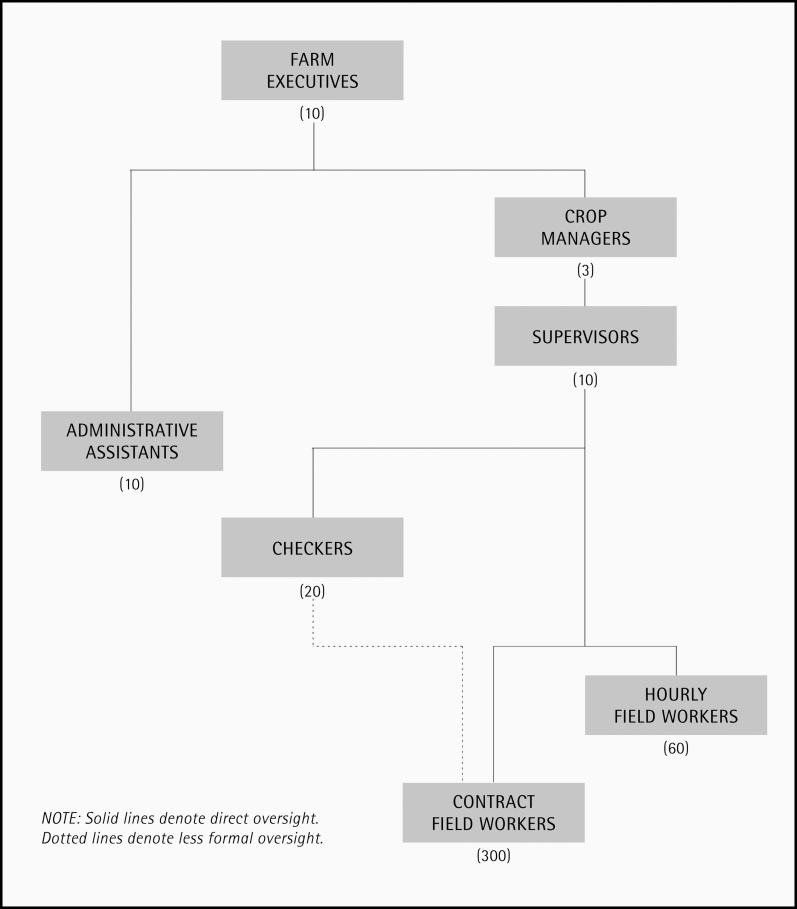
Labor Hierarchy on the Tanaka Farm